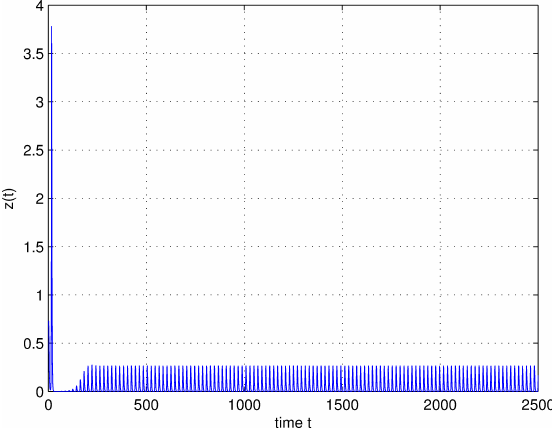
Fig. 7. The trajectory graph of system .26/ in t (cid:0) z plane with (cid:28) 1 D 0:9 , (cid:28) 2 D 0:7 and (cid:28) 3 D 0:4 . The initial value is .x.0/ D 0:8;y.0/ D 0:8;z.0/ D 0:7/